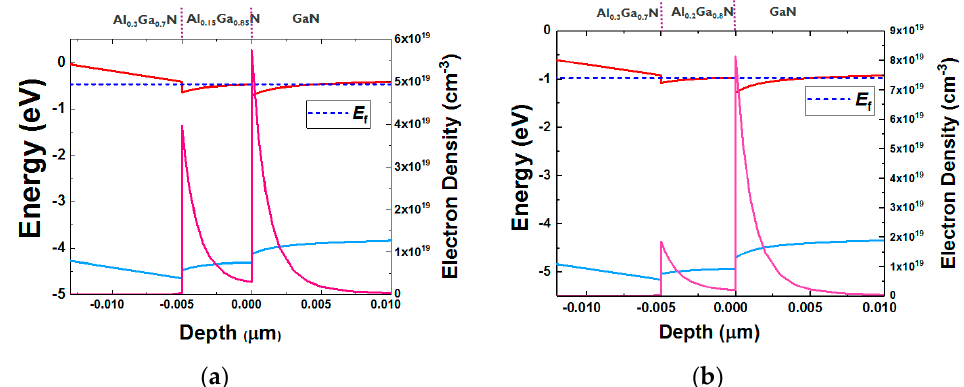
Figure 3. Simulated band diagrams with an Al 0.3 Ga 0.7 N/Al 0.15 Ga 0.85 N barrier ( a ) and an Al 0.3 Ga 0.7 N / Al 0.2 Ga 0.8 N barrier ( b ).